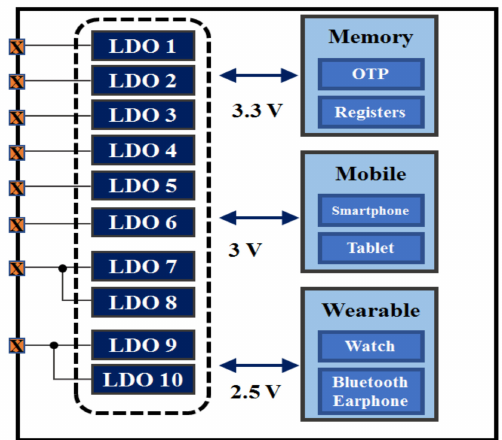
Figure 1. PMIC (Power Management Integrated Circuit)